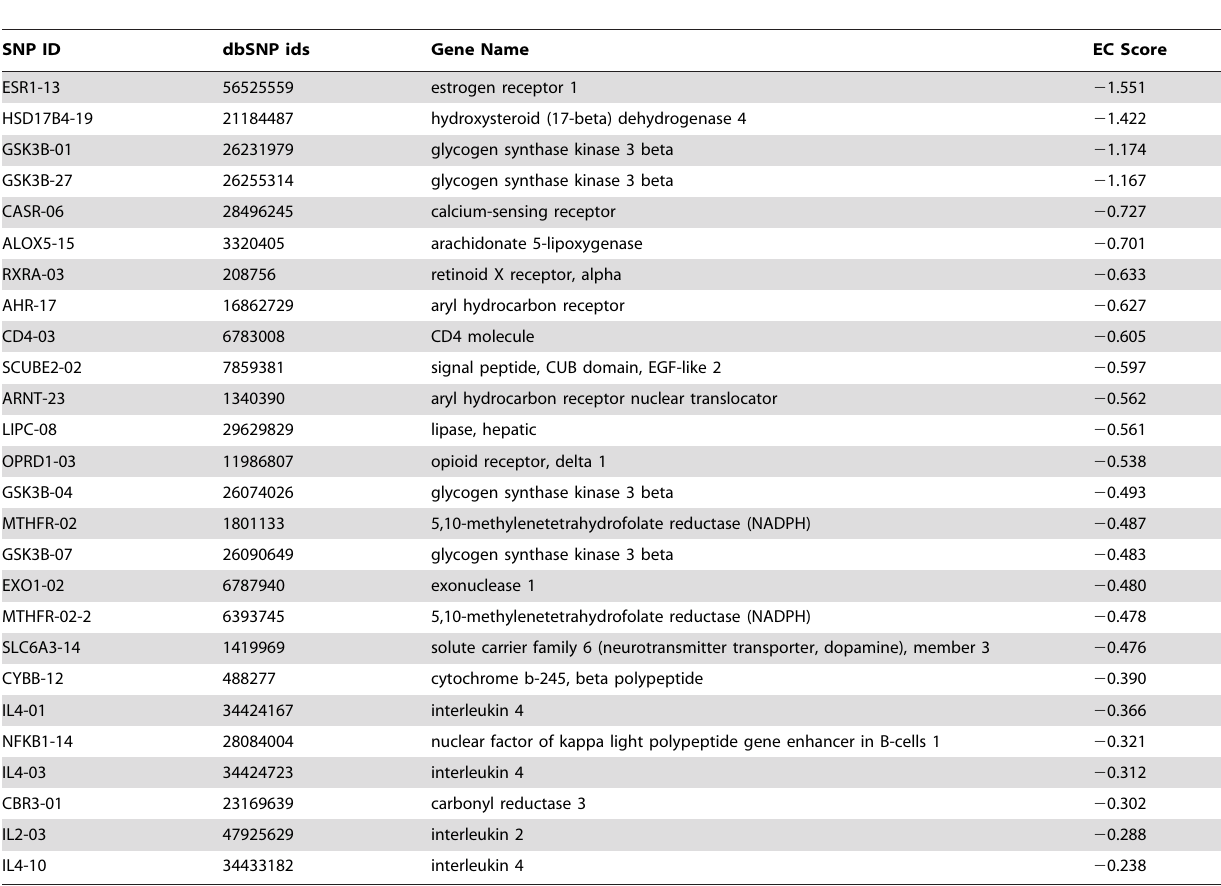
Table 1. Top SNPs selected by Evaporative Cooling (EC) as most relevant to smallpox vaccine-associated adverse